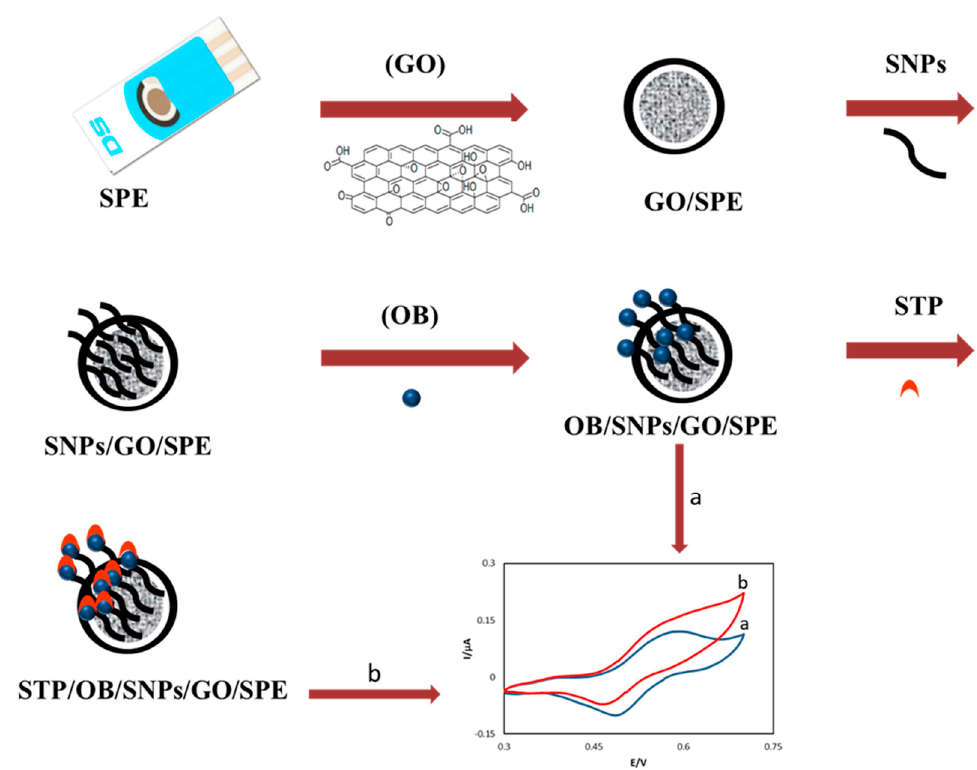
Scheme 2. The procedure of electrode preparation.